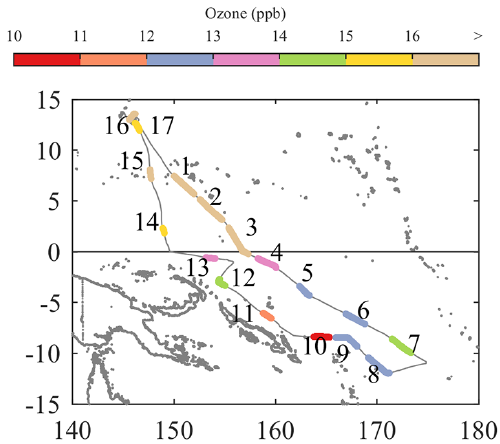
Figure 12. Flight track of RF05, with each ascent profile performed by the Global Hawk chronologically numbered and coloured by mean tropospheric ozone in each profile. The length of each coloured profile corresponds to the time the aircraft was below the tropopause in that